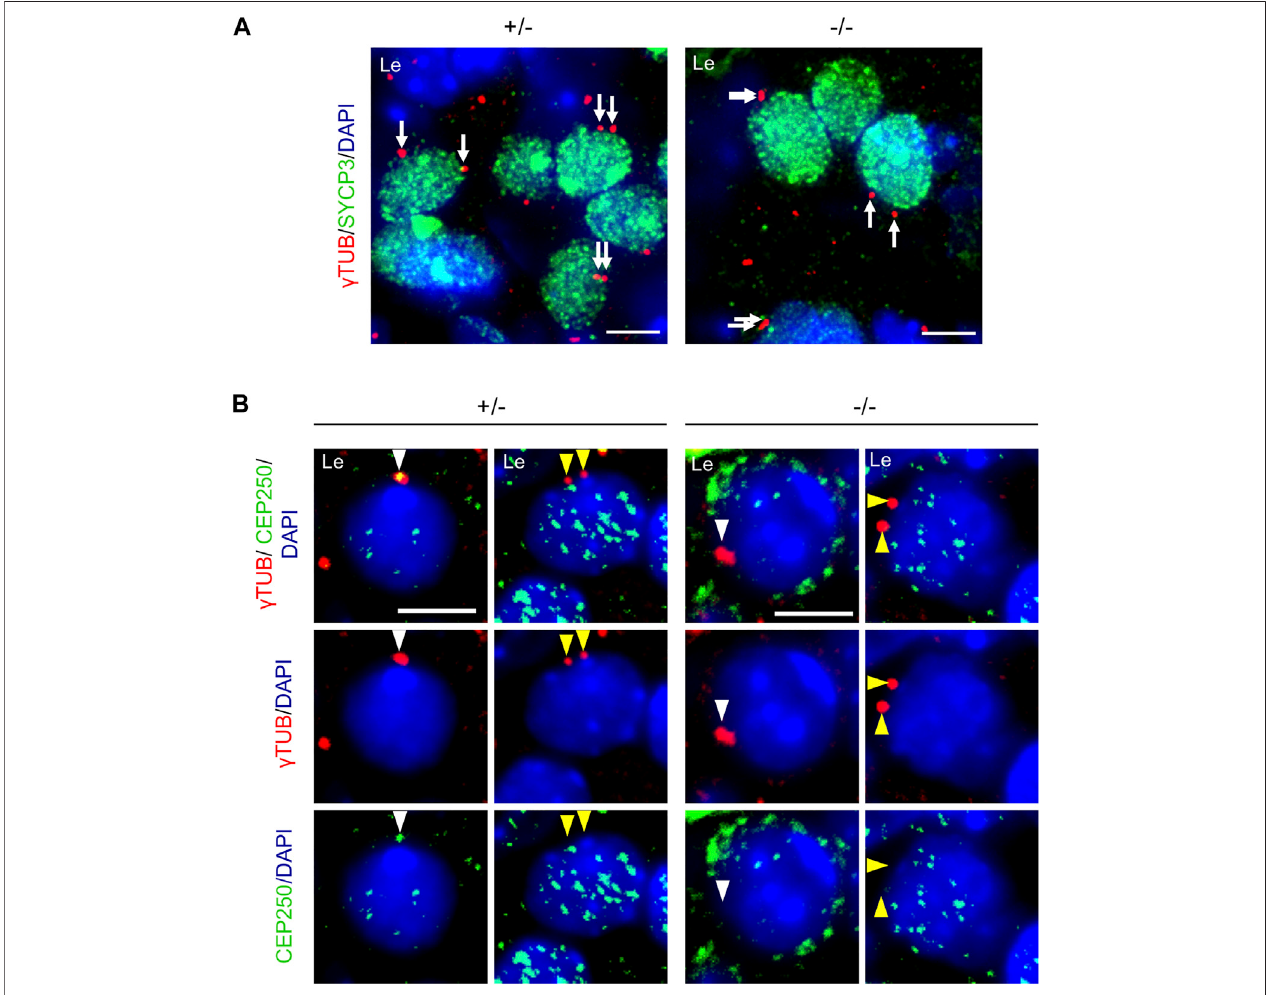
FIGURE9| Femalecentrosomes display littlecohesionatmeioticentry. (A) Immuno fl uorescencestainingof γ -tubulin( γ TUB,red)andSYCP3(green)inthecontrol (+/ − ) and mutant ( − / − ) 15.5 days post-conception (dpc) foetal ovaries. DNA is stained with DAPI. White arrows indicate γ -tubulin. Le: Leptotene. Scale bar: 5 µm. (B) Immuno fl uorescence staining of γ -tubulin ( γ TUB, red) and CEP250 (green) in the control (+/ − ) and mutant ( − / − ) 15.5 days post-conception (dpc) foetal ovaries. DNA is stained with DAPI. White arrowheads indicate cohesive γ -tubulin foci. Yellow arrowheads indicate separated γ -tubulin foci. Note that CEP250 is not present in γ - tubulin-stained area in the control oocytes when these are separated. Le: Leptotene. Scale bar: 5 µm.